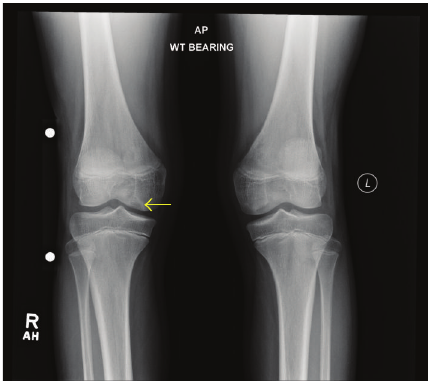
Figure 1: A 13-year-3-month-old female with FOPE zones at both proximal tibiae. Findings: AP radiograph of the bilateral knees at time of initial presentation shows a subtle lytic lesion abutting the articular surface of the right medial femoral condyle (arrow). The radiographs were initially interpreted as normal. Technique: AP radiograph kVp = 77, mAs = 4.